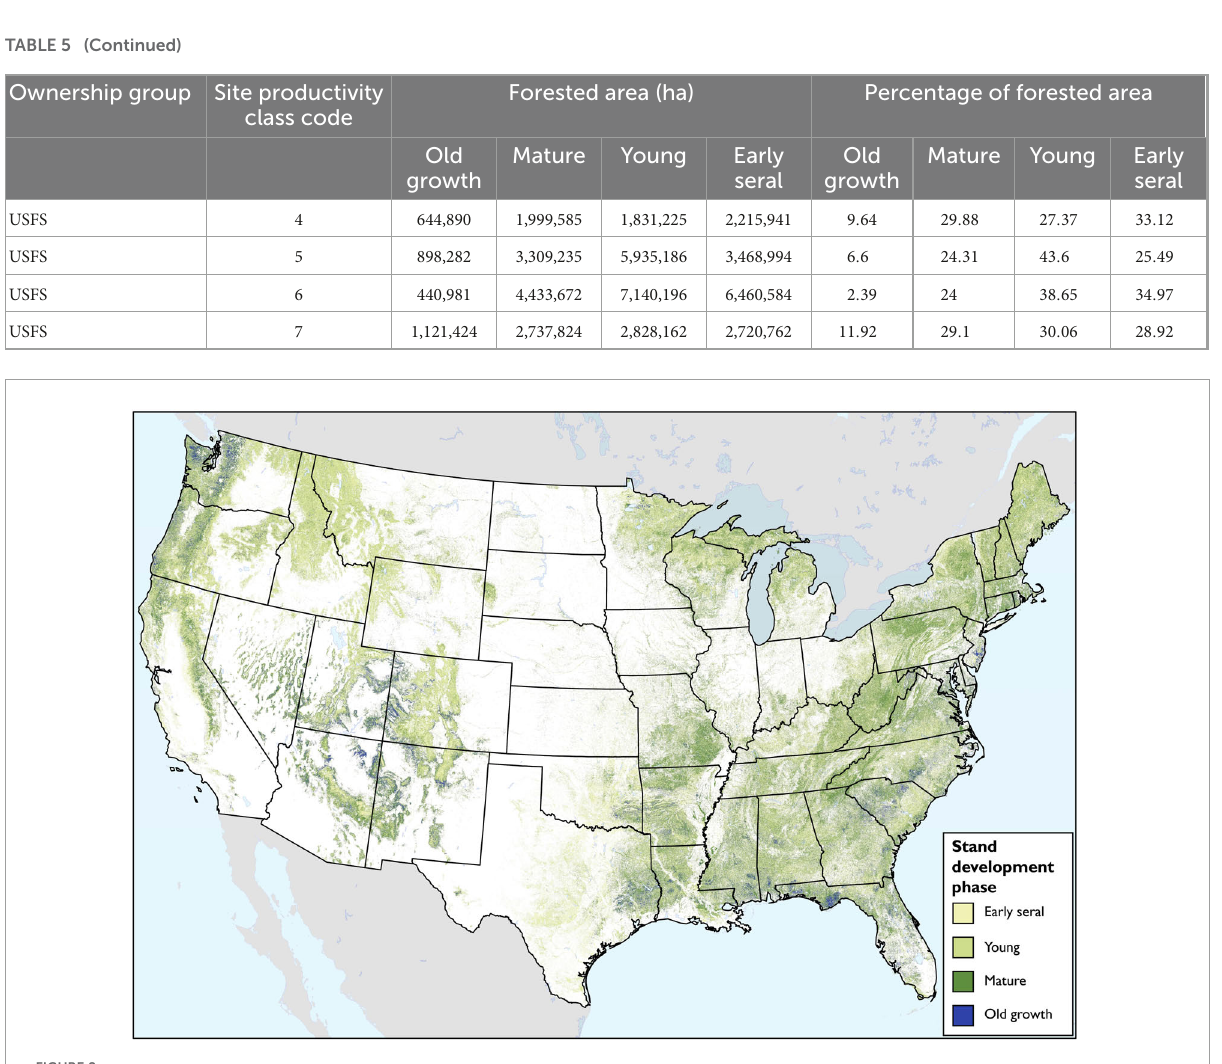
FIGURE8 Map of stand development phases across the contiguous United